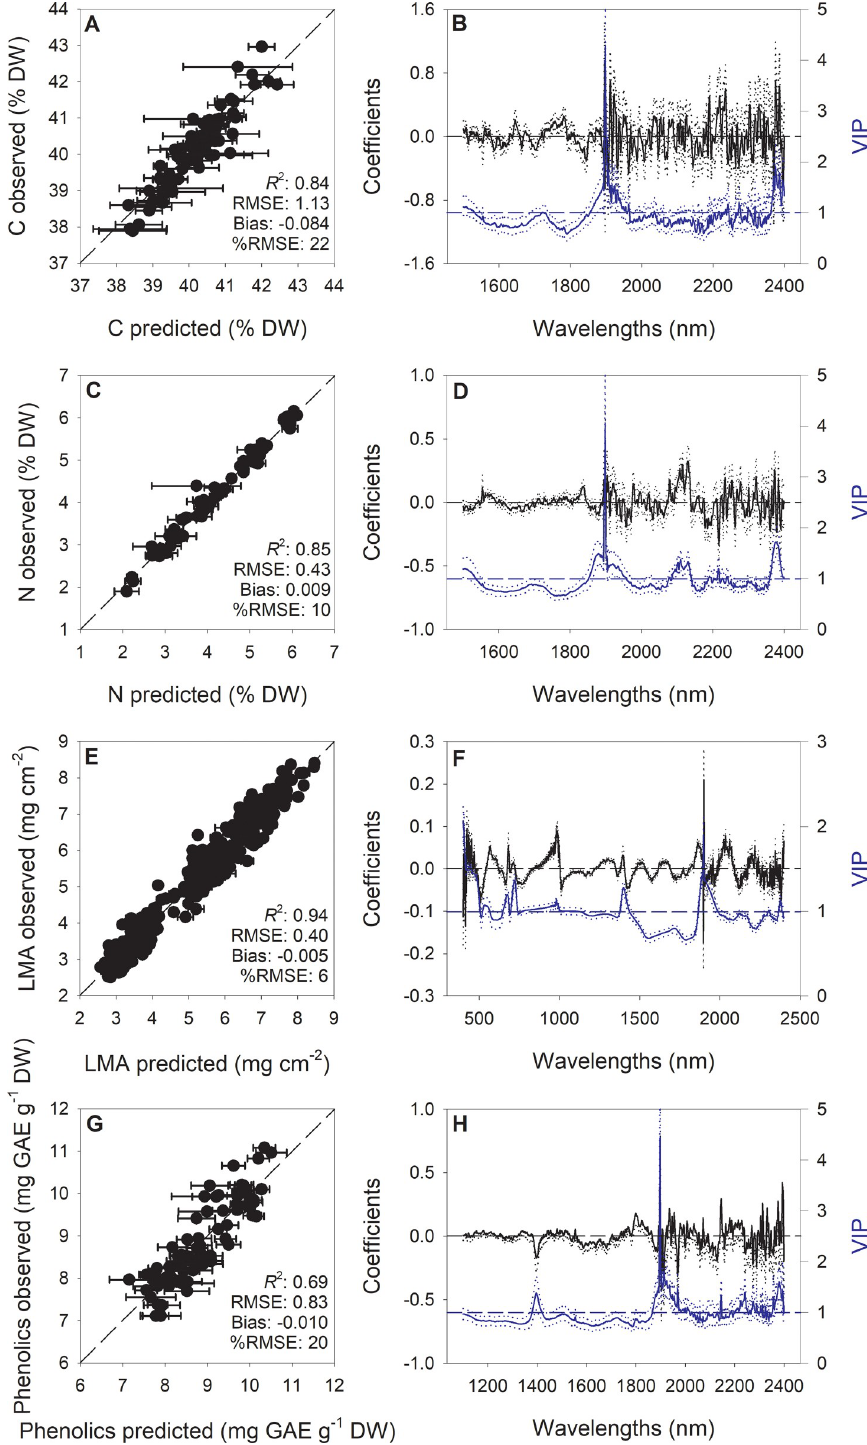
Fig 2. Observed vs predicted values, generated using partial least squares regression (PLSR), of foliar carbon (C), nitrogen (N), leaf mass per area (LMA) and phenolic concentrations in wheat (A, C, E, G); error bars for predicted values represent the standard deviations generated from 500 simulated models; dashed line is 1:1 relationship; mean